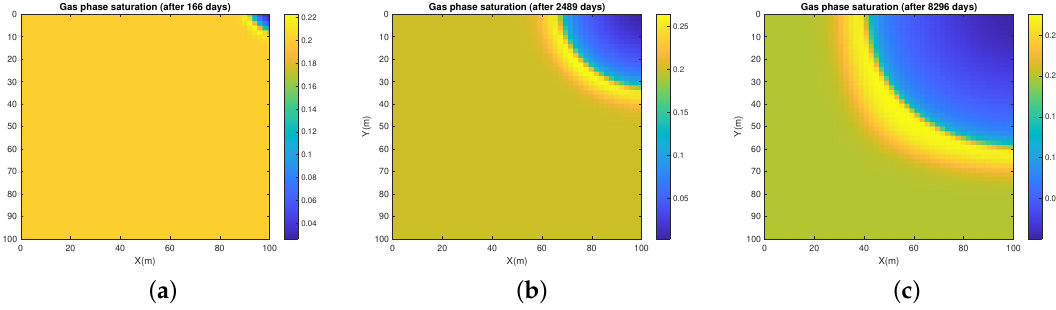
Figure 4. Gas saturation at different time for Example 1: ( a ) Gas saturation (after 166 days). ( b ) Gas saturation (after 2489 days). ( c ) Gas saturation (after 8296